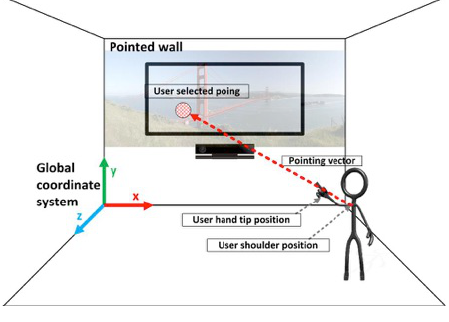
Figure 3. Pointing estimation.